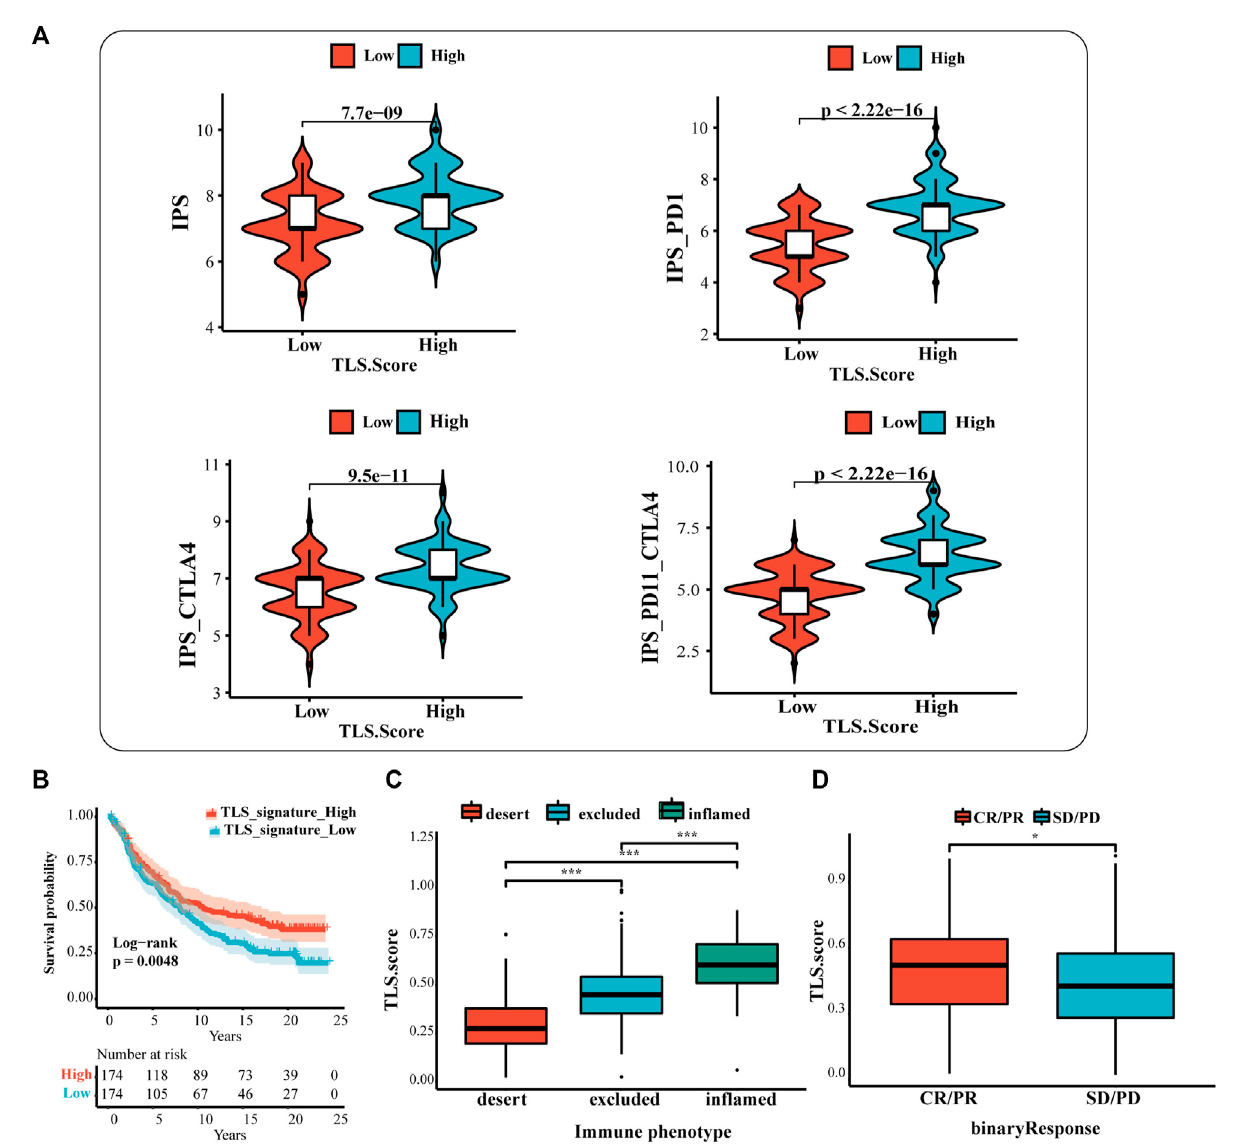
FIGURE 5 The prognostic value of TLS features in immunotherapy response. (A) The association between IPS analysis and TLS signature score. The analysis of TLS signature in the IMvigor210 cohort (B,D) : (B) The survival analysis between the high and low TLS signature subgroups; (C) Box plots of TLS signature score in the desert, excluded and in fl amed immune phenotypes; (D) Distribution of ISS in groups with different anti-PD-L1 clinical response statuses. (NS: no signi fi cance, p p < .05, pp p < .01, and ppp p <